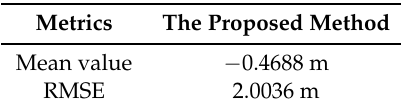
Table 2. Quality assessment of the estimation